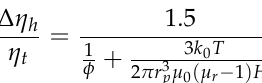
Figure 5. Magnetic fluid lubrication film viscosity – temperature and viscosity – pressure characteris- tics.